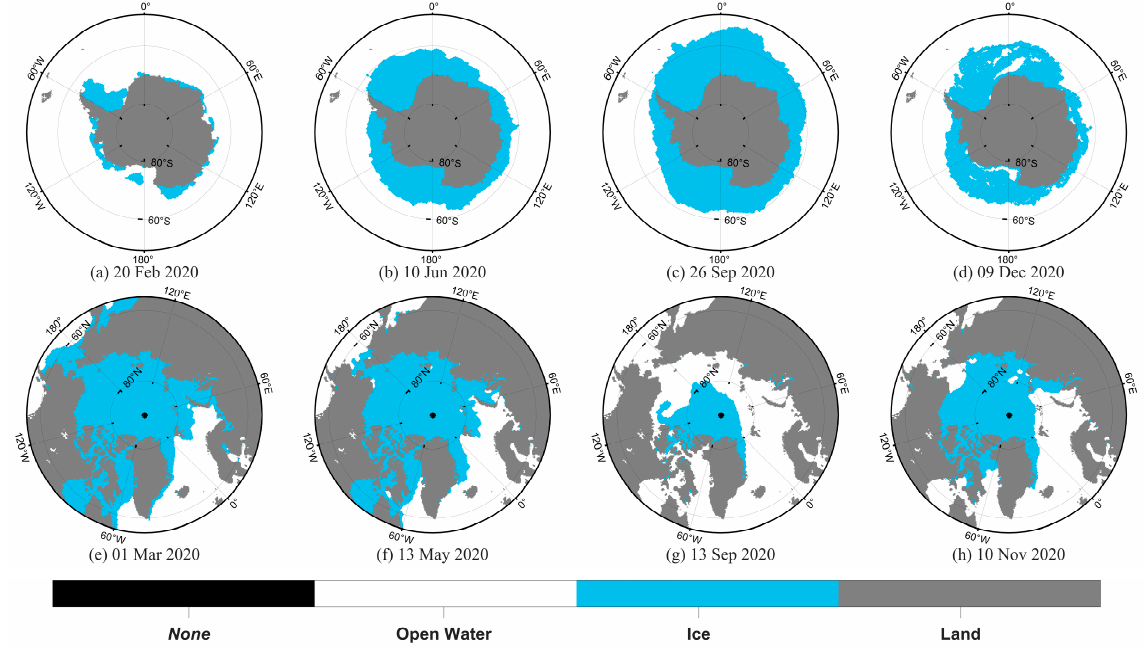
Figure 8. Example daily polar sea ice extent obtained on the basis of multisource scatterometer data. Gray pixels represent land; white pixels represent water; blue pixels represent sea ice; and the black hole in the Arctic is due to there being no coverage by scatterometers.